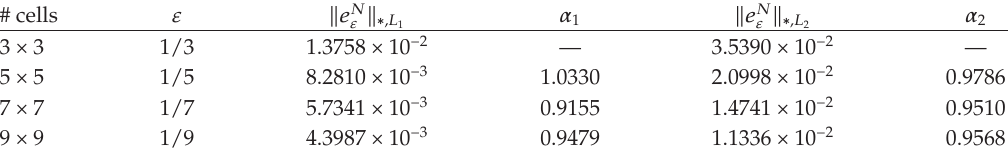
Table 3: Comparison of the macro-model to the micro-model for di ff erent values of ε Example 3.4. # cells ε (cid:10) e N